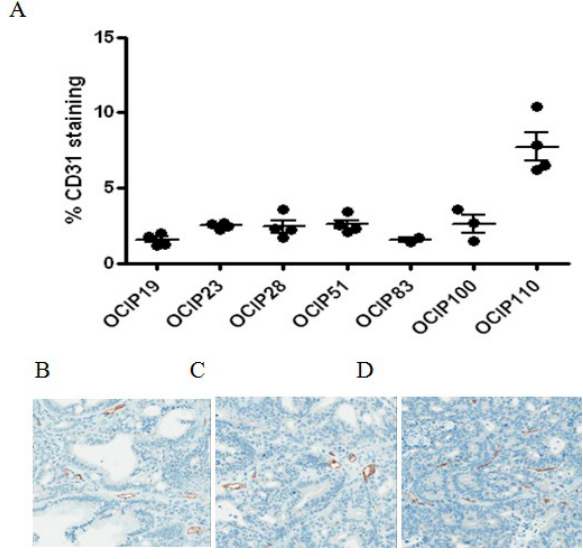
Figure 3. Patient-derived pancreatic xenograft models differ in microvessel density. ( A ) Percentage of CD31 of the patient-derived xenograft models. Each point represents a single tumor. In these models, staining for CD31 indicating vessel density shows little difference between the tested models and shows no correlation with tumor hypoxia. Representative sections of ( B ) OCIP19, ( C ) OCIP23 and ( D ) OCIP51 stained for